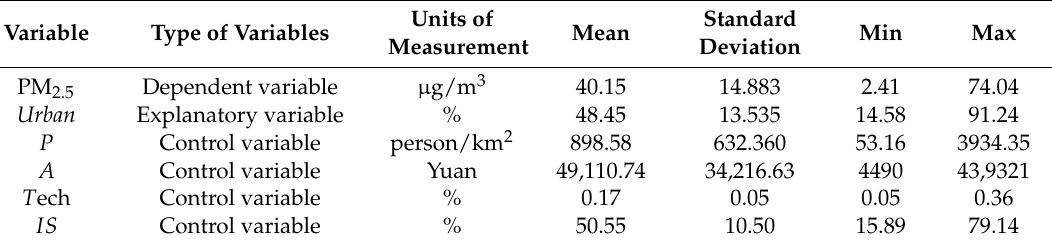
Table 1. Summary